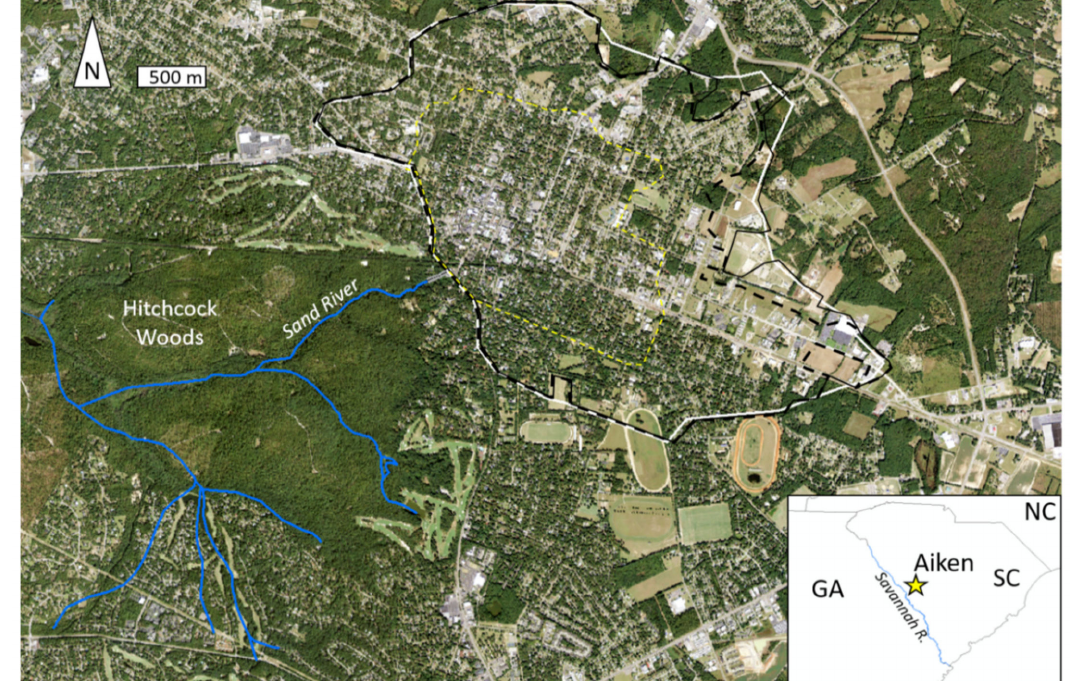
Figure 1. The Sand River is a first-order tributary of the Savannah River. The Sand River drains a 9.0 km 2 area including the downtown business district and neighboring suburbs. The river runs through the Hitchcock Woods, a 2000 acre forest preserve. The dashed yellow and black lines mark the increased extent of urbanized watershed area in 1930 and 1960, respectively. Similarly, the solid black and white lines show the extent of the watershed in 2002 and